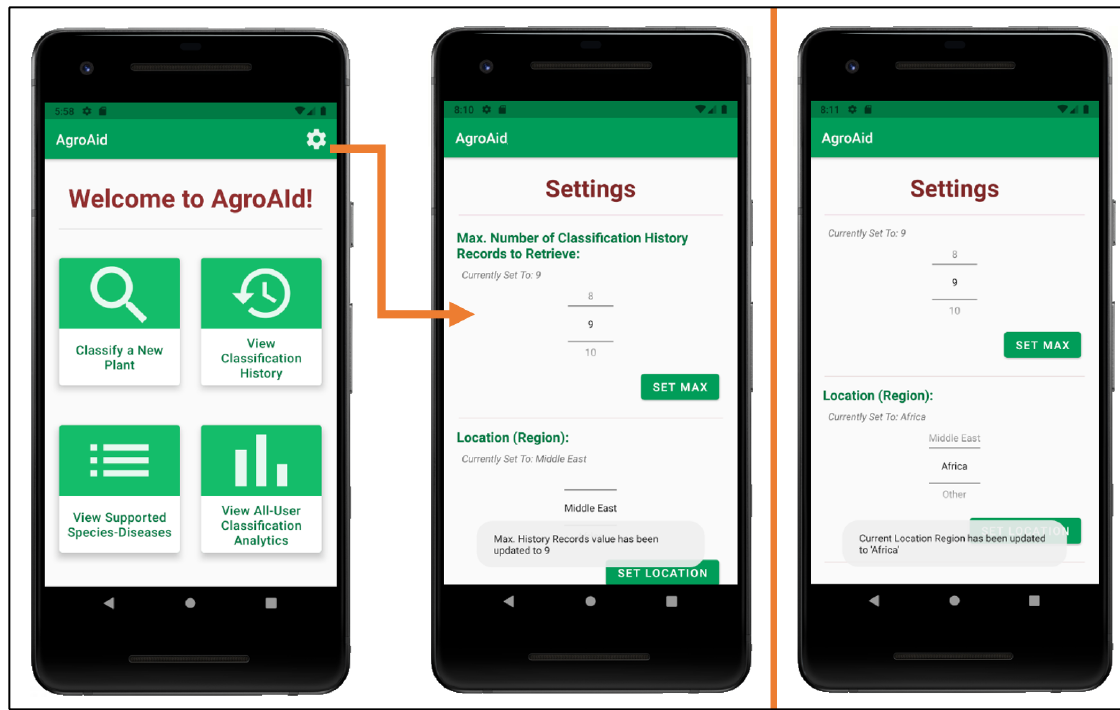
Figure 30. Configuring user settings (number of history records and location region).